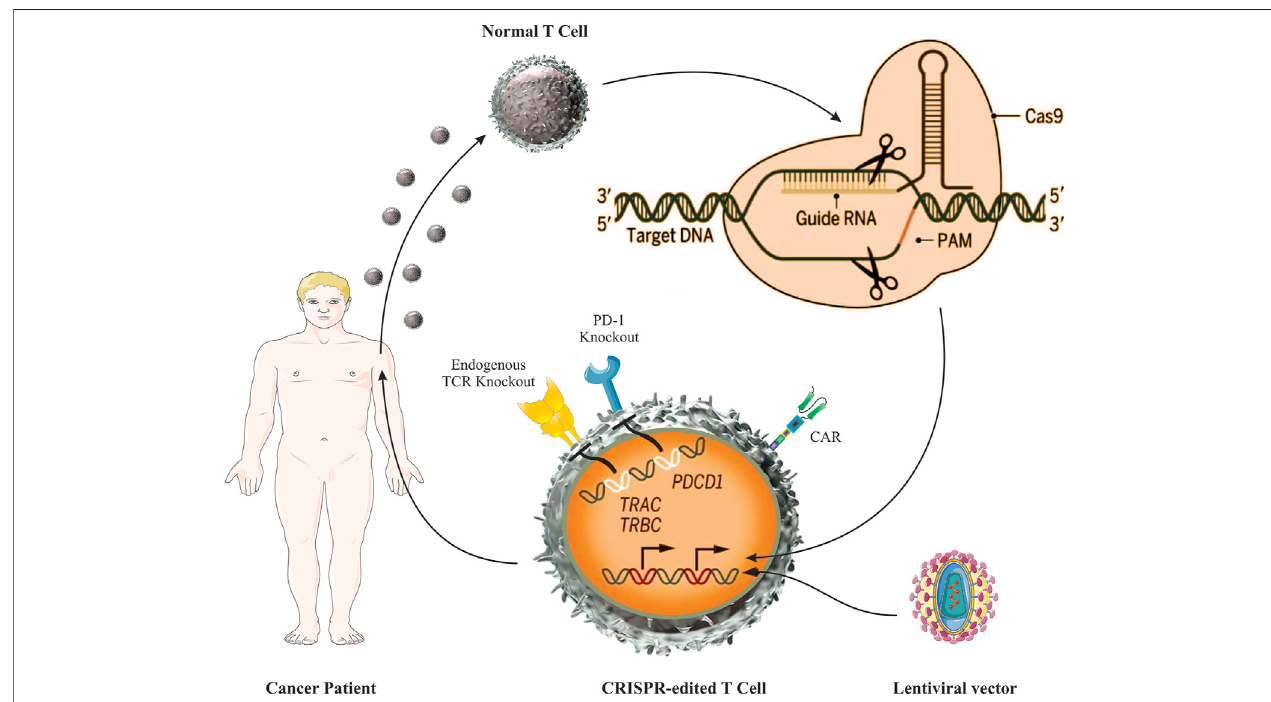
FIGURE1| CRISPR-Cas9engineeringofchimericantigenreceptor(CAR)Tcellsforcancertherapy.Tcellscanbeprocuredfromthebloodofapatientwithcancer or from healthy donors. Firstly, CRISPR-Cas9 ribonuclear protein complexes loaded with the responding sgRNAs can be electroporated into the normal T cells, leading to the ablation of TRAC and PDCD1 (encoding PD-1) loci. After that, T cells can be transduced with a lentiviral vector to express a CAR speci fi c for a tumor-associated antigen (TAA). Eventually, the engineered CAR T cells can be injected into the patients suffering from